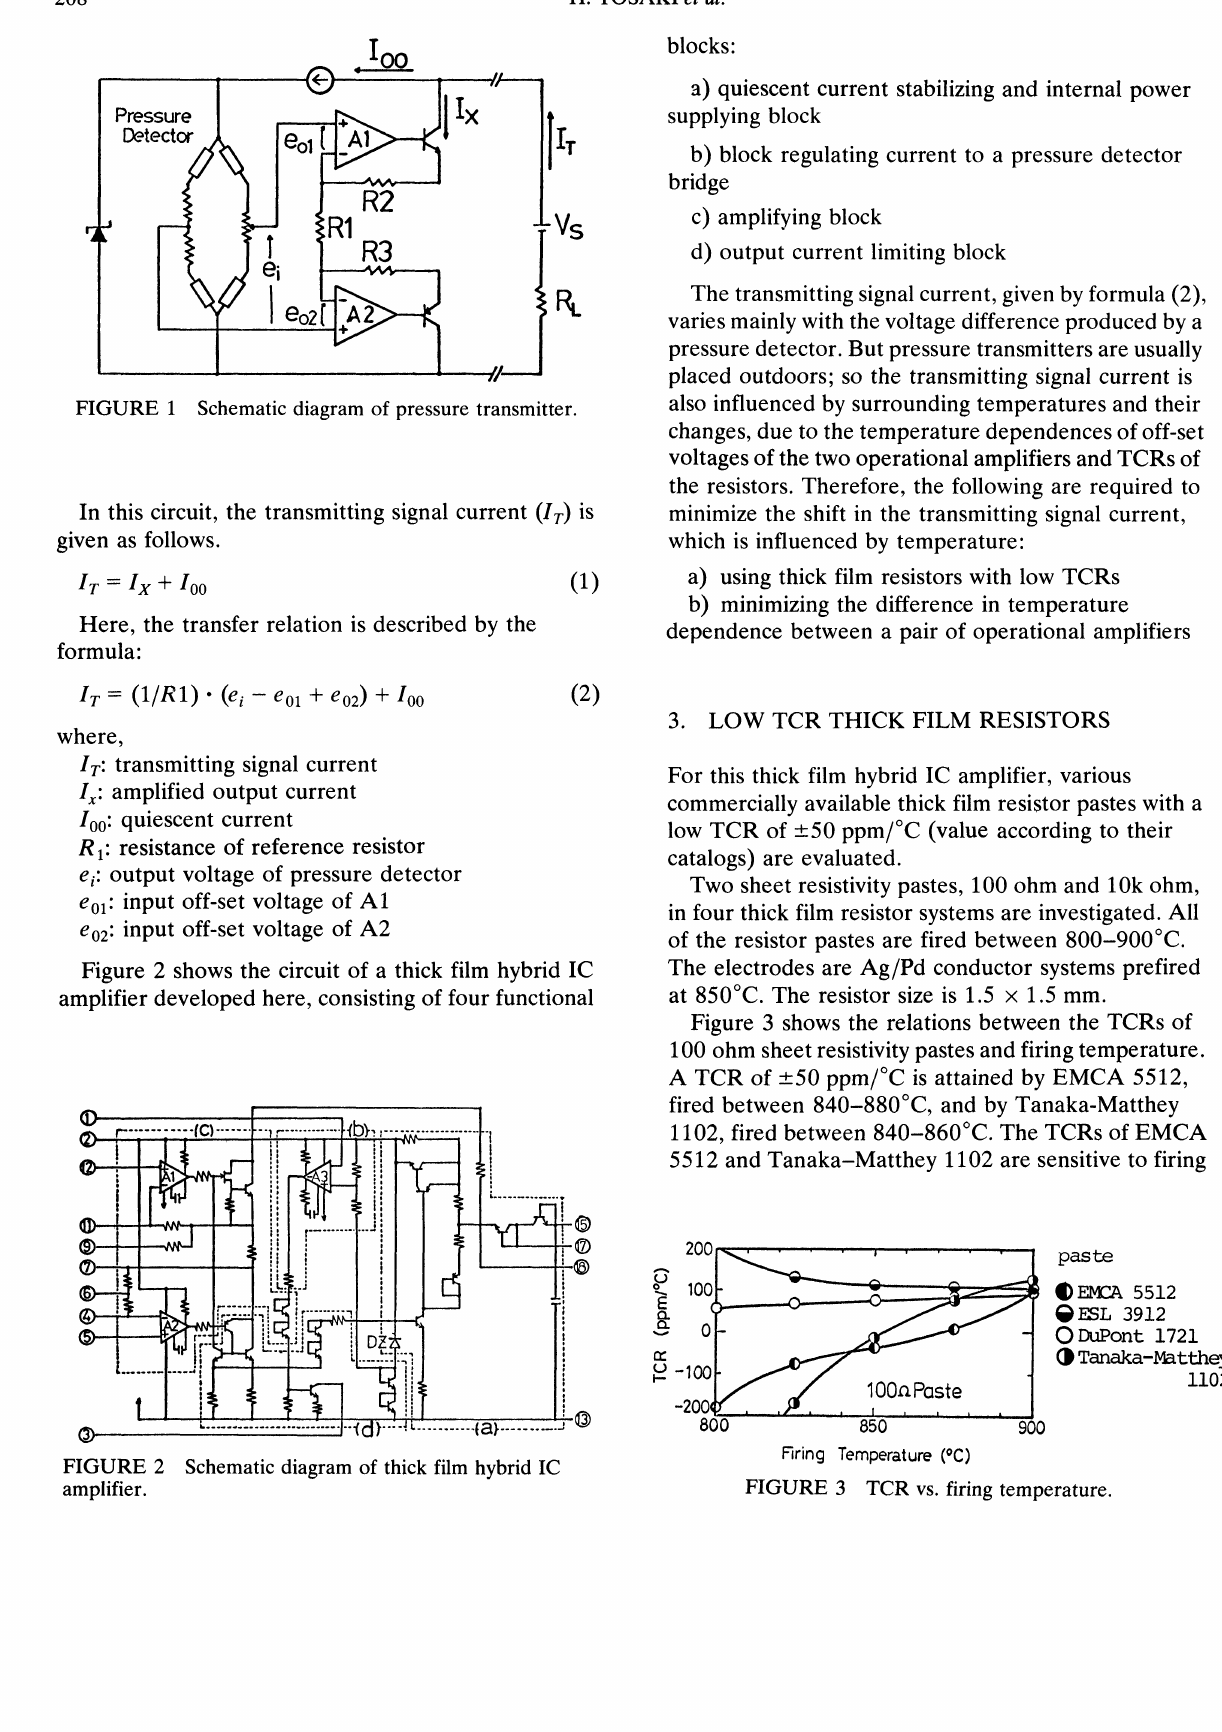
FIGURE Schematic diagram of pressure transmitter.